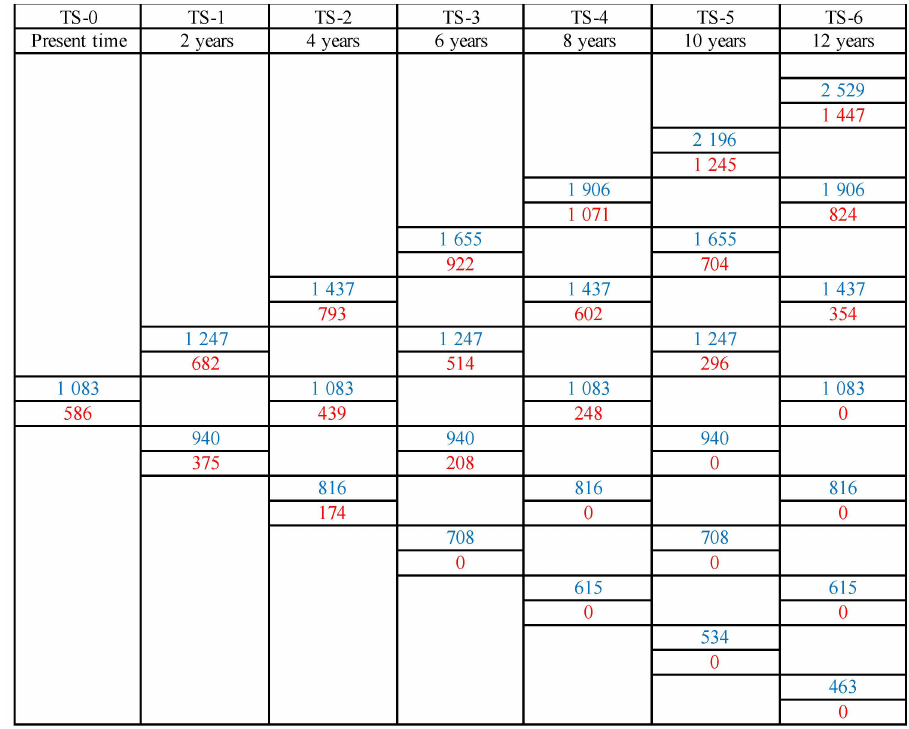
Figure 10. Binomial lattice model of SC–1 baseline configuration (Million USD).